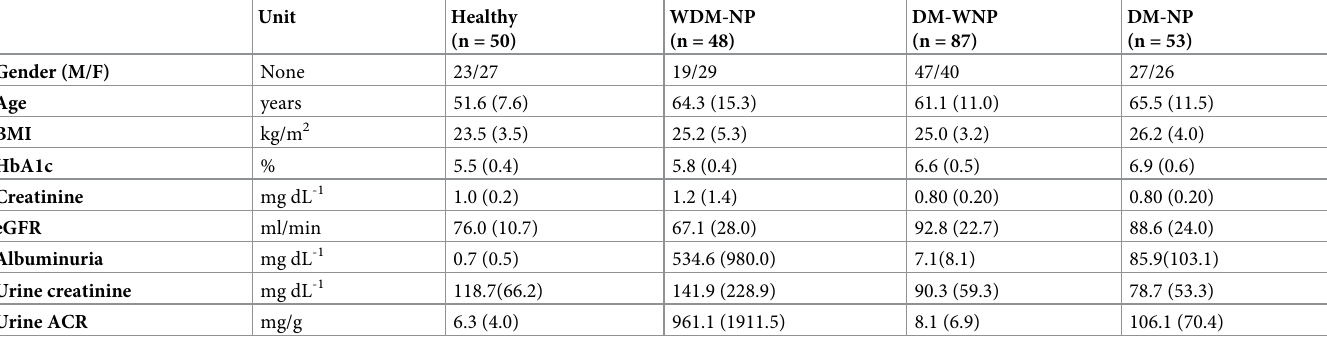
Table 1. Clinical and biochemical parameters for the healthy, WDM-NP, DM-WNP, and DM-NP